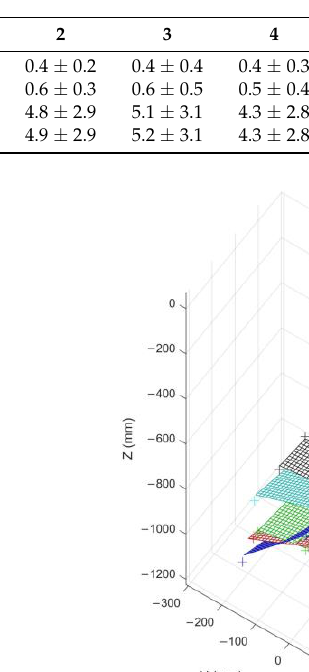
Table 1. Average errors of 3D PoR estimation in centimeters of every tester.